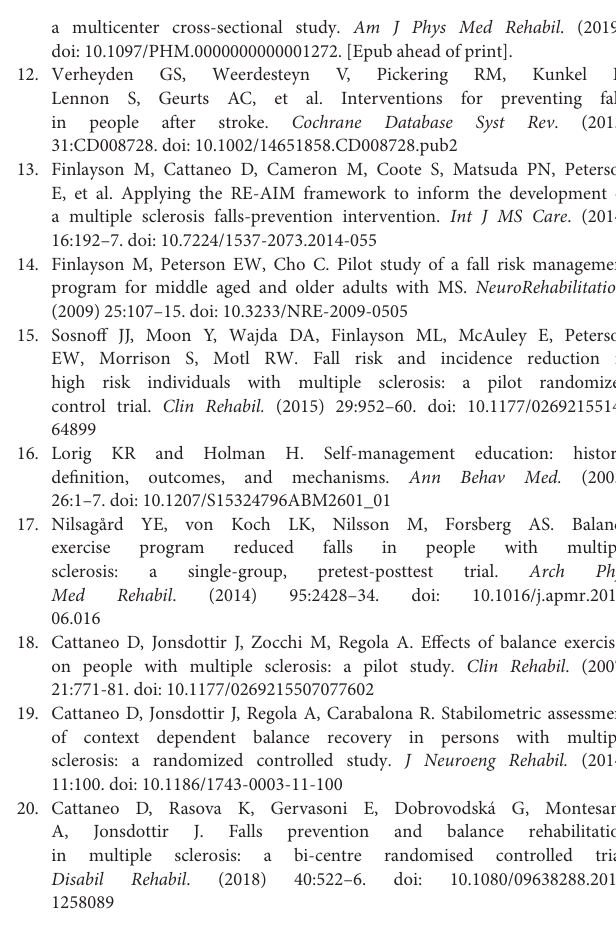
Supplementary Figure 1 | Hazard ratios for time to fall for education vs. control group according to